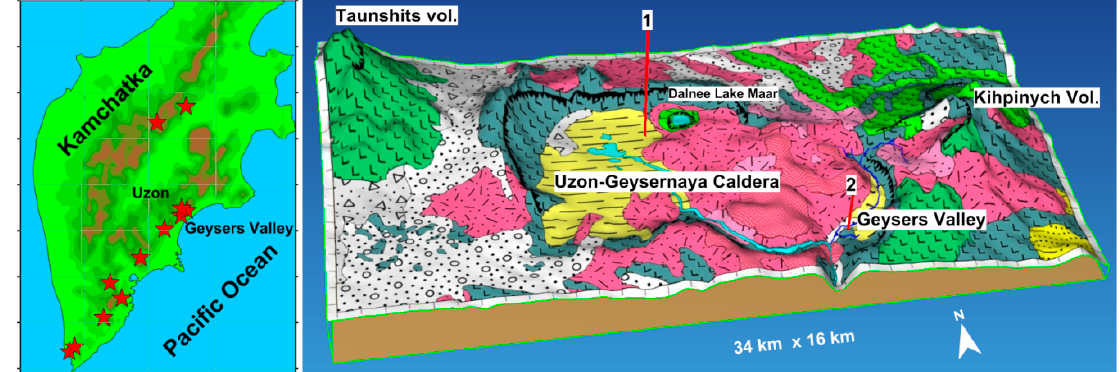
Figure 1. Kamchatka high temperature geothermal systems ( left ) and schematic 3D view of the Uzon–Geysernaya caldera ( right ). The geological units are shown by the colors: alluvial and glacial deposits (light gray), caldera lake deposits (Q 34 ) (yellow), rhyolite–dacite extrusions ( ξ Q 34 and αξ Q 34 ) (pink), pre-caldera tuffs and sedimentary deposits (gray), and basalt-andesite lavas (green) ( α Q 31–2 , α Q 33 , and Q 33 ust). Geysers under monitoring: 1—Shaman geyser area, 2—Bolshoy, Velikan geysers area.